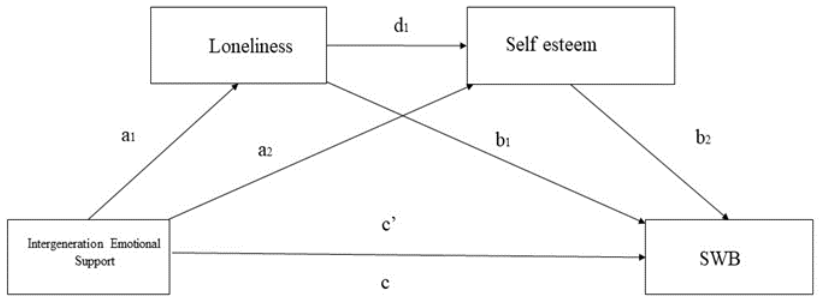
Figure 1. Model to test our hypotheses. Note: a, b, c, c’, and d represent path coefficients. Note1: a 1 : represents the path from IES to loneliness; a 2: represents the path from IES to; b 1 represents the path from loneliness to SWB; b 2 represents the path from Self-esteem to SWB; d 1 represents the path from loneliness to Self-esteem. Note2: SWB represents subjective well-being.